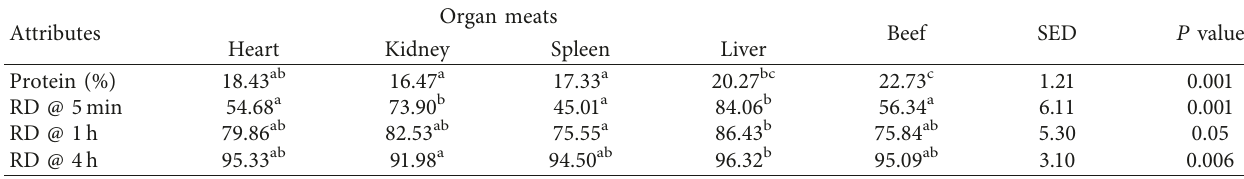
Table 1: Experiment 4: protein content and digestibility of bovine organ meat and muscle meat.